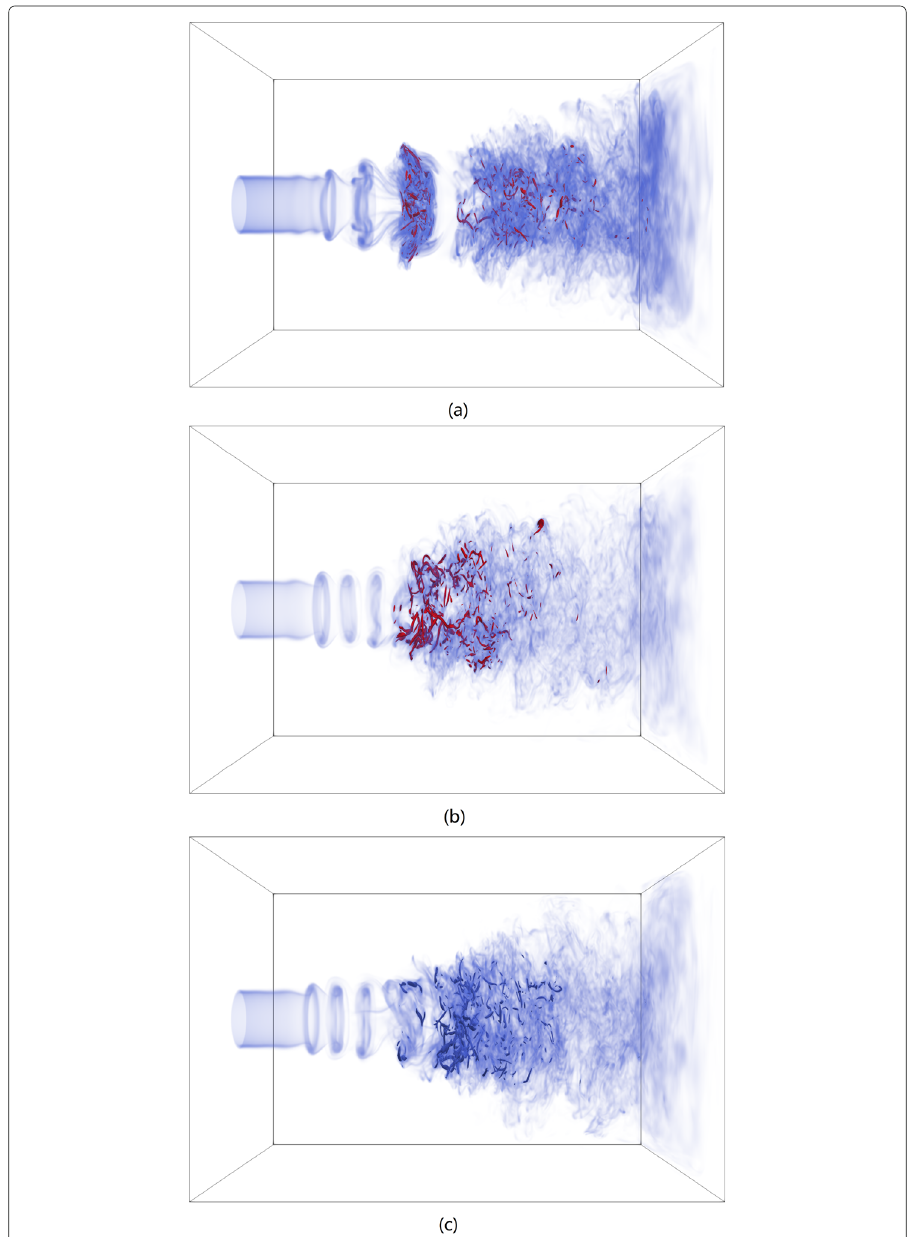
Fig. 1 Volume visualization of enstrophy and overtime for all the large components (parts of color highlight). Most components have a volume of 20 cells to 30 cells. a the start time step of the combustion simlulation. b the middle time step. c the end time